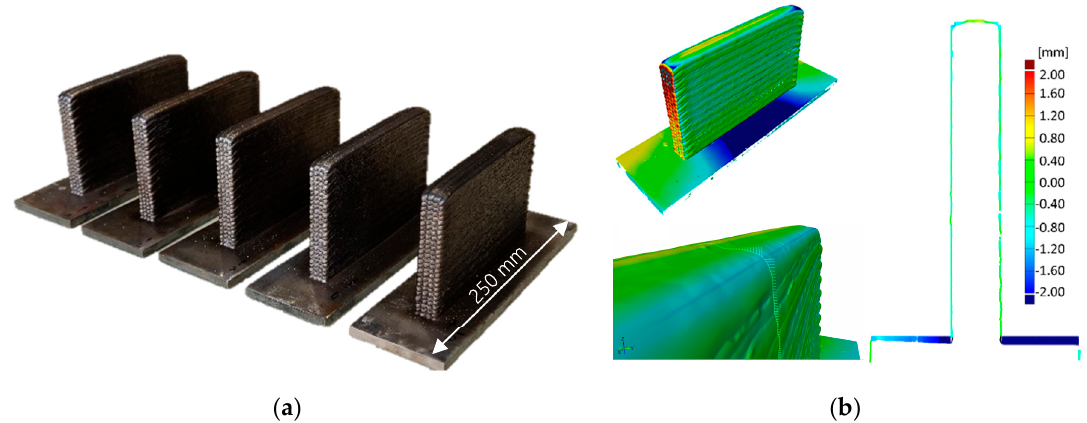
Figure 8. ( a ) Finished test walls; ( b ) false color representation of the actual geometry.